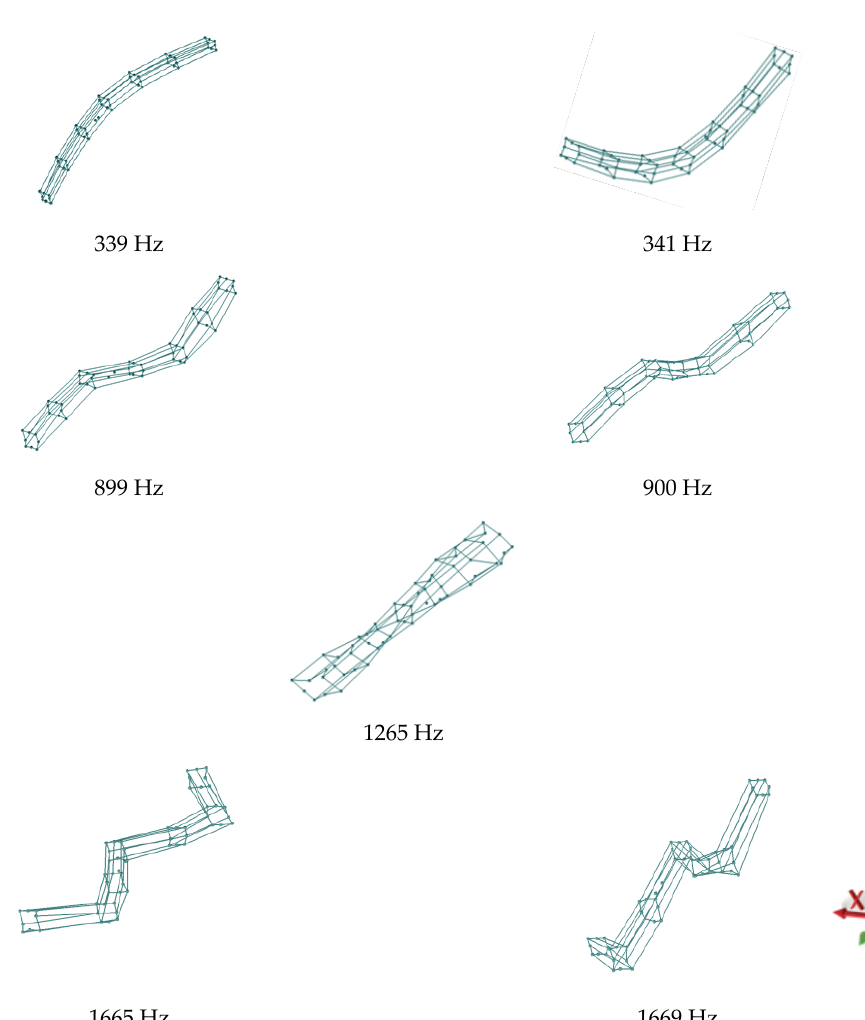
Figure 5. Experimentally determined mode shapes of the steel–polymer concrete beam. Table 4. Parameters of the modal model of the steel–polymer concrete beam. Mode Shape Natural Frequency